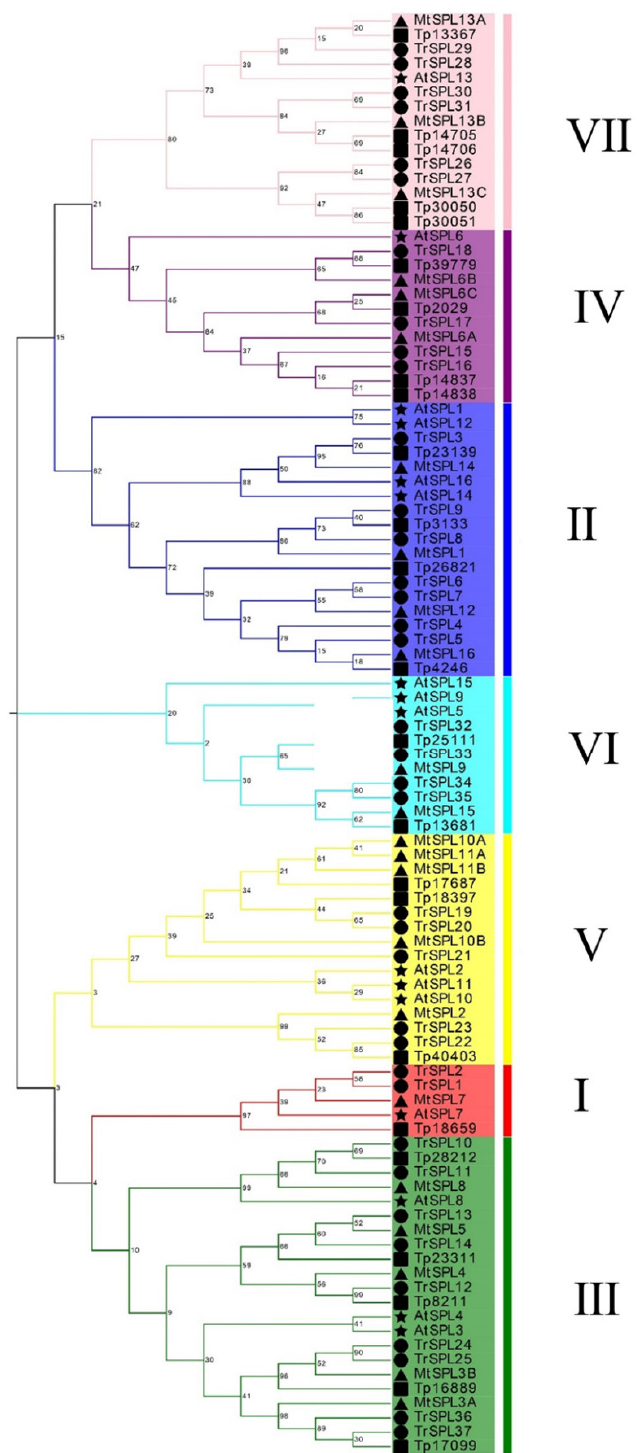
Figure 2. Phylogenetic analysis of SPL proteins in A. thaliana , T. repens Trifolium pratense , and M. truncatula . Phylogenetic trees were plotted using the neighbor-joining (NJ) method with a bootstrap value of 1000. A total of 100 genes were divided into 7 clades (I–VII) and identified with different colors. The black circle, pentacle, square and triangle represent T. repens , A. thaliana , Trifolium pratense , and M. truncatula